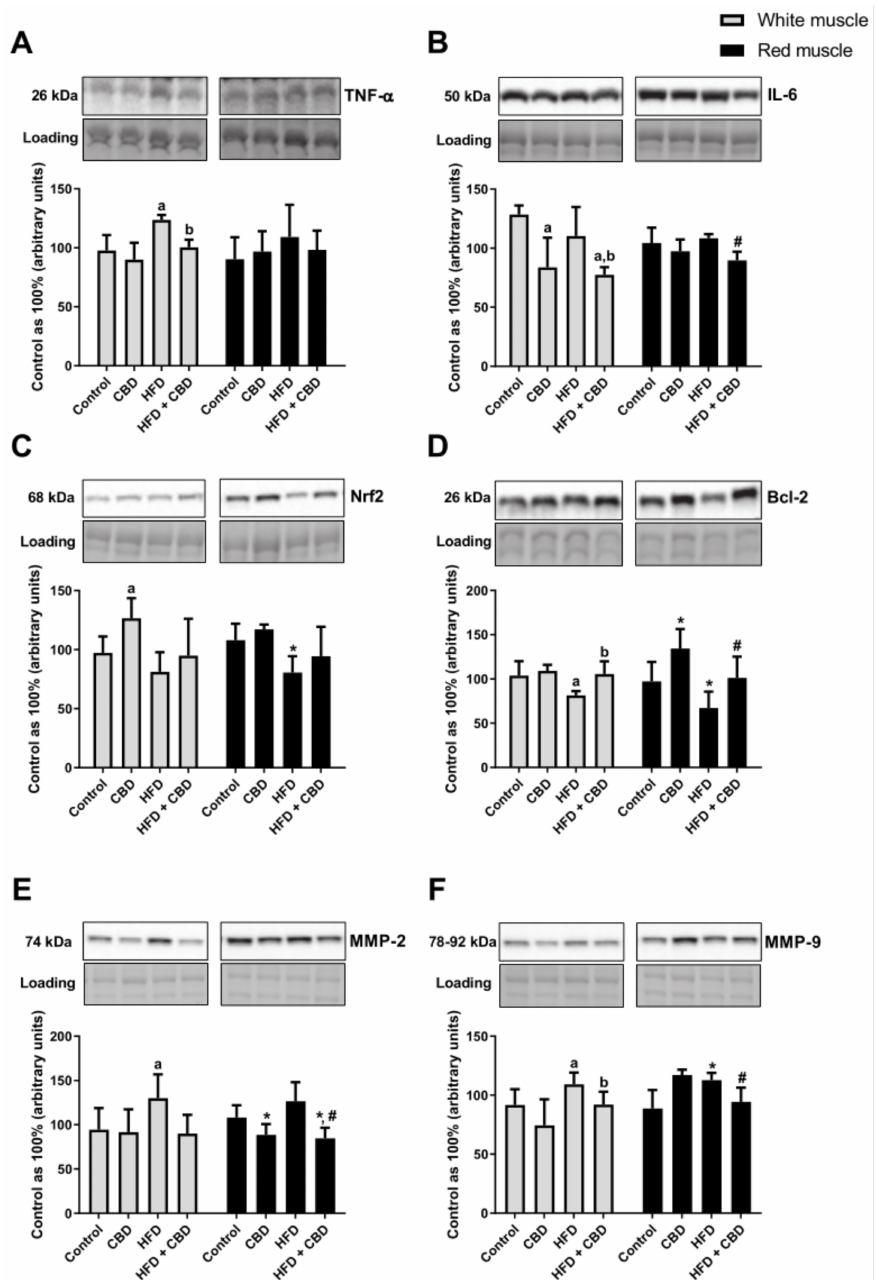
Figure 5. Intramuscular changes in the total expression of proteins involved in the inflammatory pathway, i.e., of ( A ) tumor necrosis factor α (TNF- α ), ( B ) interleukin 6 (IL-6), as well as ( C ) nuclear factor erythroid 2-related factor 2 (Nrf2), ( D ) B cell lymphoma 2 (Bcl-2), ( E ) matrix metalloproteinase-2 (MMP-2) and ( F ) matrix metalloproteinase-9 (MMP-9) in the white and red gastrocnemius muscles in the control (standard diet) and high-fat diet (HFD) groups. The total expressions of the abovemen- tioned proteins are presented as percentage differences compared to the control group which was set as 100%. The data are expressed as mean values ± SD, n = 6 in each group. a p < 0.05 indicates a significant difference: the control group vs. the examined group in the white gastrocnemius muscle; b p < 0.05 indicates a significant difference: HFD vs. HFD + CBD in the white gastrocnemius muscle. * p < 0.05 indicates a significant difference: the control group vs. the examined group in the red gastrocnemius muscle; # p < 0.05 indicates a significant difference: HFD vs. HFD + CBD in the red gastrocnemius